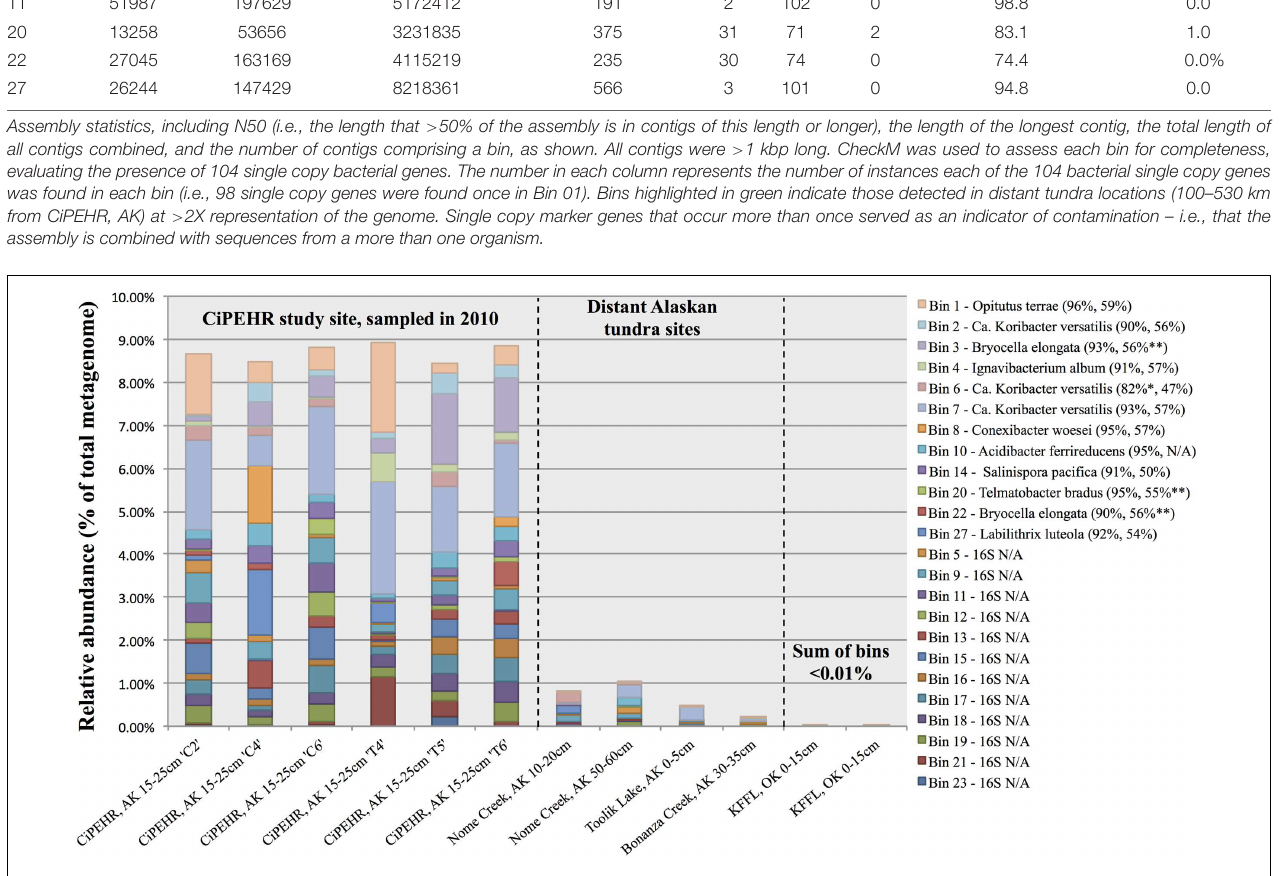
FIGURE 3 | Abundance of individual populations (bins) in various Alaskan tundra metagenomes determined by read mapping. Results were obtained by the number of sequences that matched a population genome at ≥ 200 bp and ≥ 98% nucleotide identity for CiPEHR metagenomes ( ≥ 90 bp and ≥ 98% nucleotide identity for metagenomes at other locations), divided by the number of reads used as query (all merge-able paired-end sequences ≥ 200 bp at CiPEHR; sequences ≥ 90 bp at other sites). Bin abundance is given for two KFFL, Oklahoma metagenomes for contrast. Taxonomic affiliation is provided for bins with full or partial 16S ribosomal sequence, along with the average amino acid identity (AAI) to the corresponding genome. ∗ Nucletide identity given corresponds to the 23S sequence because the 16S gene was not available. ∗∗ AAI is derived from comparison to a genome that is not the same as the 16S match because a genome sequence was not available for these references; instead, the next closest match was